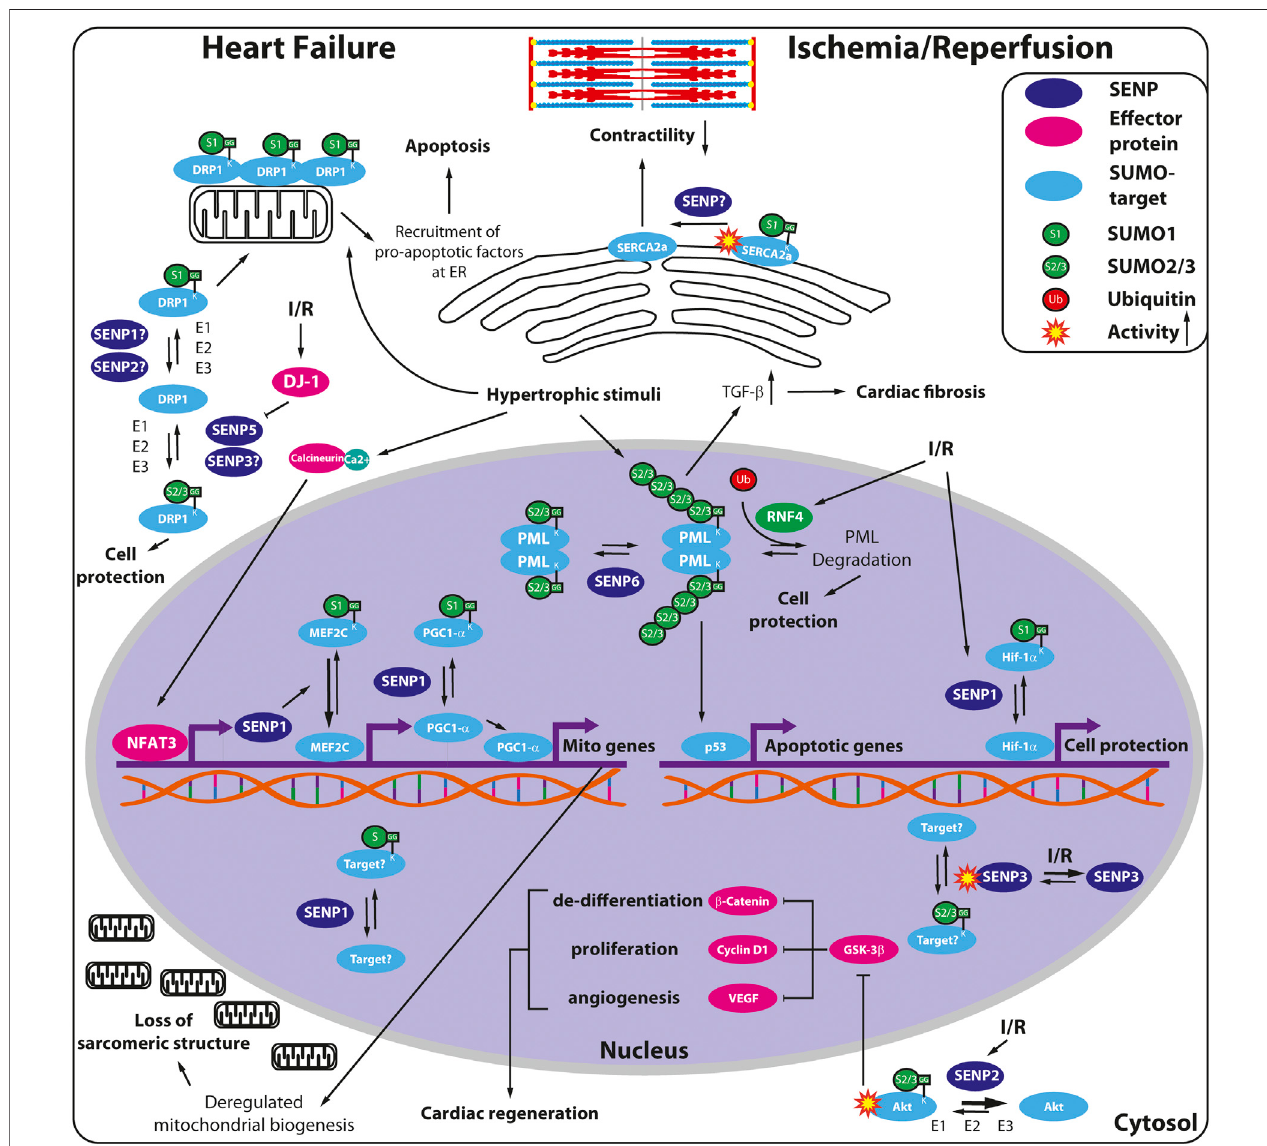
FIGURE 3 | Overview of SENP functions in heart failure and cardiac ischemia-reperfusion injury. Hypertrophic stimuli induce SENP1 in a calcineurin/NFAT3- dependentmannerinthefailingheart. SENP1deSUMOylatesand therebyactivates theMADS-box transcription factor MEF2CfacilitatingPGC1- α expression, whereas the transcriptional activity of PGC1- α is directly enhanced by SENP1. Hyperactivation of PGC1- α leads in turn to deregulated mitochondrial biogenesis and loss of the sarcomericstructure.Moreover, decreased SUMOylationofSERCA2a reducesenzymestability and activity thereby worsening cardiac contractility in heartfailure. Hypertrophicstimuli,byregulatingvariousSENPs,mayalsochangethebalancebetweenSUMO1-andSUMO2/3-modi fi edDRP1,withSUMO1-DRP1oligomerizingon the outer mitochondrial membranes thereby creating an ER-mitochondrial platform for recruitment of pro-apoptotic factors, ultimately leading to apoptosis. In contrast, SUMO2/3-DRP1 gets removed from mitochondria thereby protecting the cells from apoptosis. Hypertrophic stimuli also induce the stabilization of PML nuclear bodies (PML-NB) leading to p53 activation and subsequent apoptosis, accompanied, on the other hand, by TGF- β release and cardiac fi brosis. In contrast, RNF4, the SUMO- targeted E3 ubiquitin ligase exerts a protective effect through ubiquitin-mediated degradation of PML or other polySUMOylated targets. In cardiac ischemia/reperfusion (I/R)injury,SENP1deSUMOylatesandstabilizesHif-1 α ,animportantprotectivefactorpromotingcardiomyocytesurvival.SENP2removesSUMO2/3fromAktrendering theAkt pathway lessactive incardiomyocytes.Thus,SENP2 inhibition promotes cardiac de-differentiation,proliferationand angiogenesis viatheactivationof β -catenin, cyclin D1 and VEGF signaling, respectively. The activity of redox-sensitive SENP3 is regulated in I/R but the speci fi c cardiac targets of SENP3 remain to be clari fi ed. Notably,RNF4isinducedbyI/RandcounteractsapoptosismostlikelybyaffectingthePML-p53axis.DJ-1(alsoknownasPARK7),acytoprotectivefactoralsoinduced in I/R, shifts the balance toward SUMO2/3-DRP1 via SENP5 inhibition, thereby preventing mitochondrial fi ssion and subsequent apoptosis.